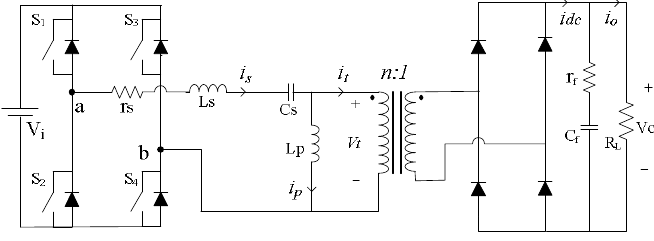
Figure 1. An LCL-type resonant dc/dc converter with a capacitive output converter.